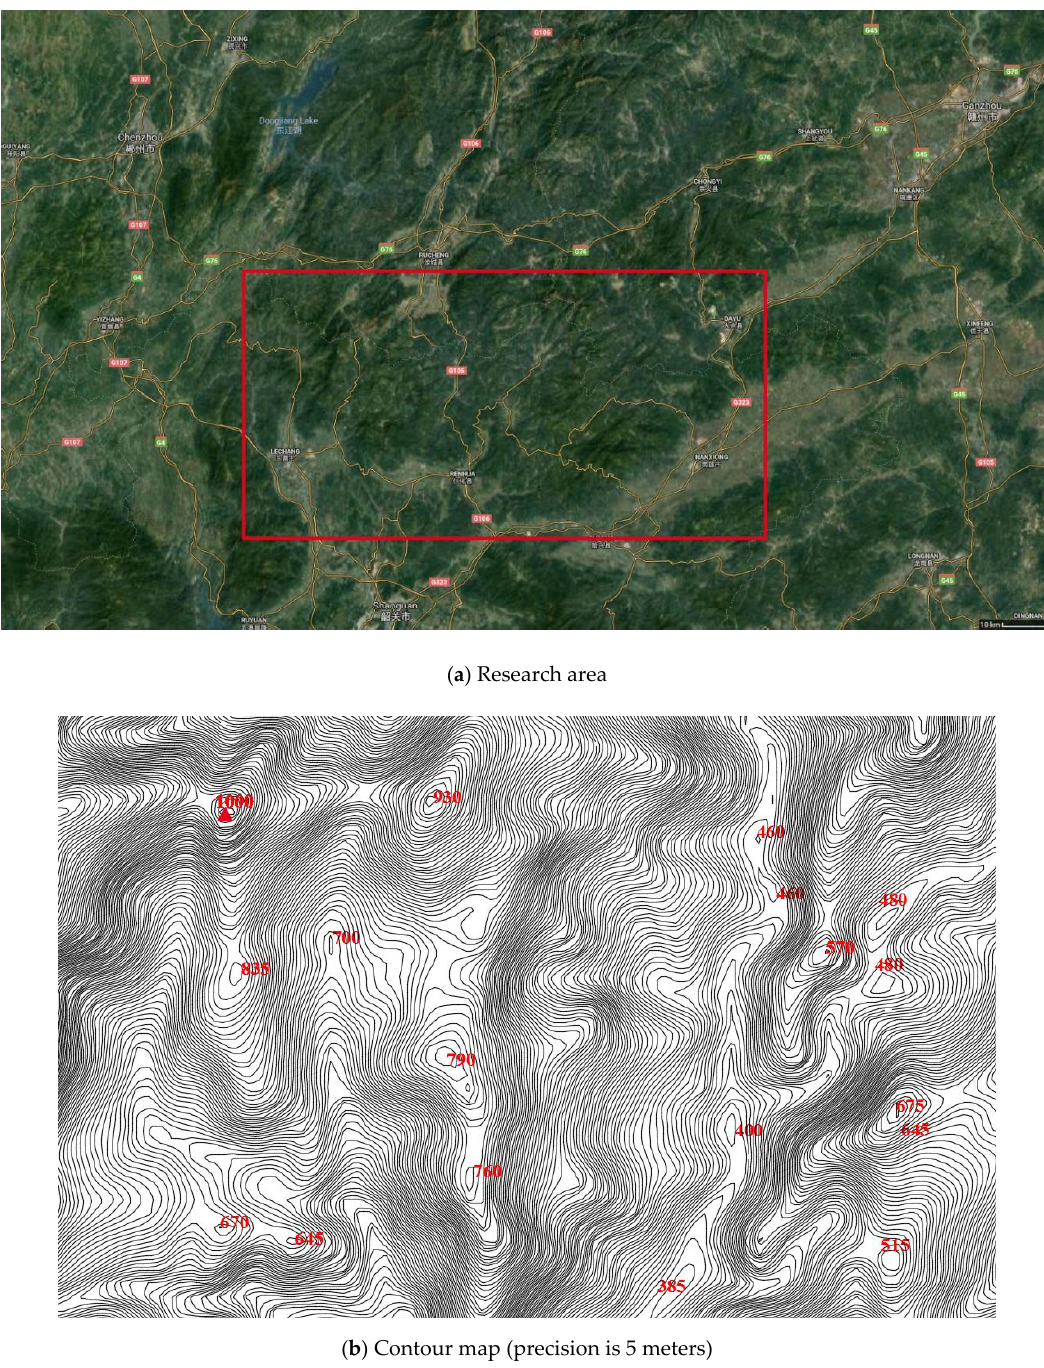
Figure 14. Major research areas in northern Guangdong province.